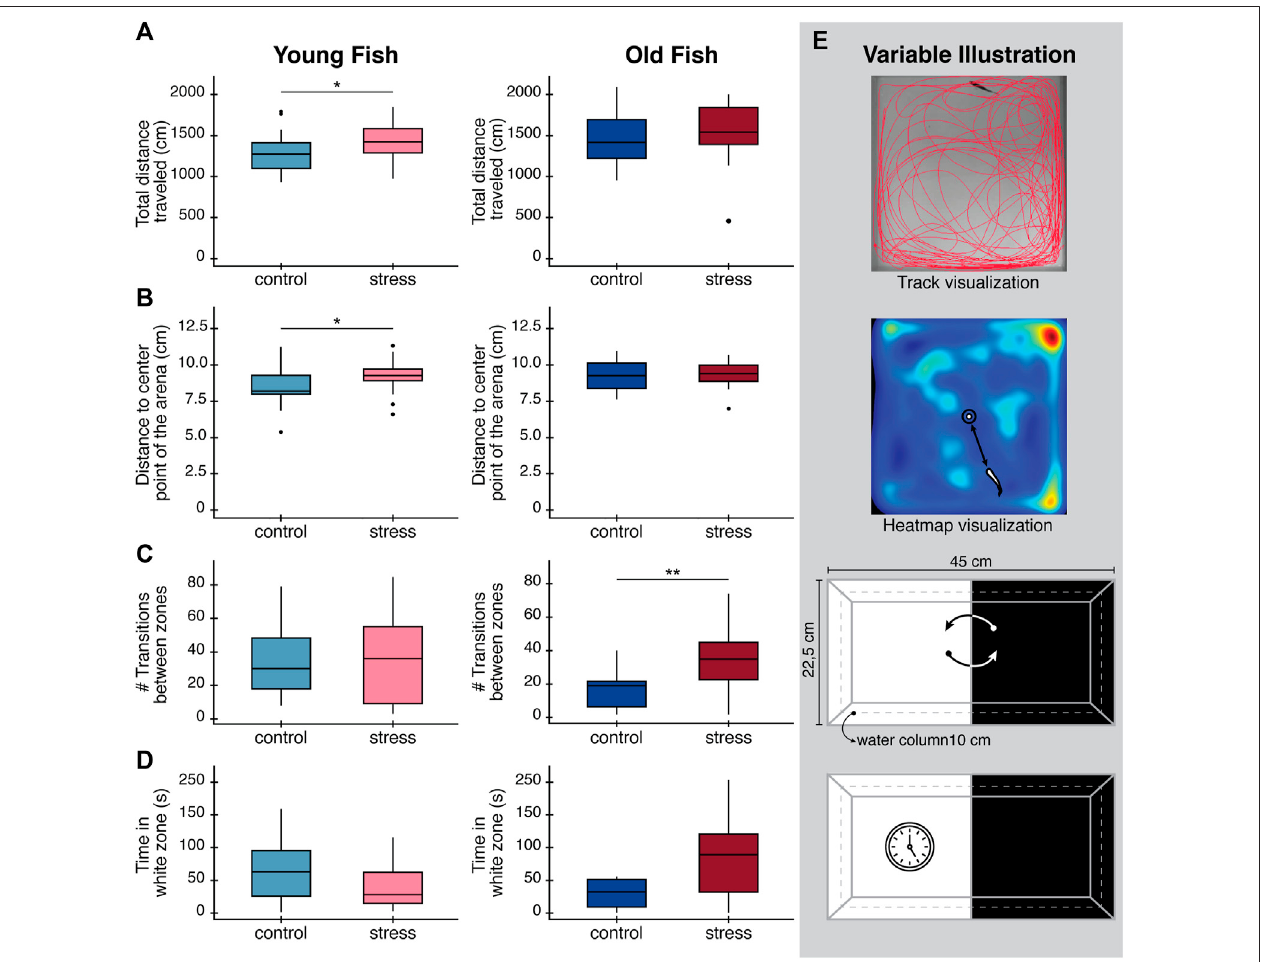
FIGURE2| Effectsinbehavioralparameters(open fi eldtestandlight/darkpreferencetest)inzebra fi shafterexposuretoachronicstressprotocolatday9. (A) Total distance traveled in the open fi eld test. (B) Distance to the center of the arena to evaluate thigmotaxis. (C) Total number of transitions between white and black zones during light/darkpreferencetest. (D) Totaltimespentinthewhitezoneofthetankduring light/darkpreferencetestasanexploratorybehavior.Boxplotsinpanels (A – D) , are drawn such that the upper and lower whiskers limit interquartile range (Q1, Q3) and the line represents the median (Q2). (E) Diagrams illustrating variable being measuredineachcase.Top:trackvisualizationusedtoobtainthetotaldistancetraveledofzebra fi sh.Middle:heatmapvisualizationandhowdistancetothecenterpoint of the arena was de fi ned. Bottom: Illustration of the number of transitions between the white and the black zones, and time spend in the white zone only. All results